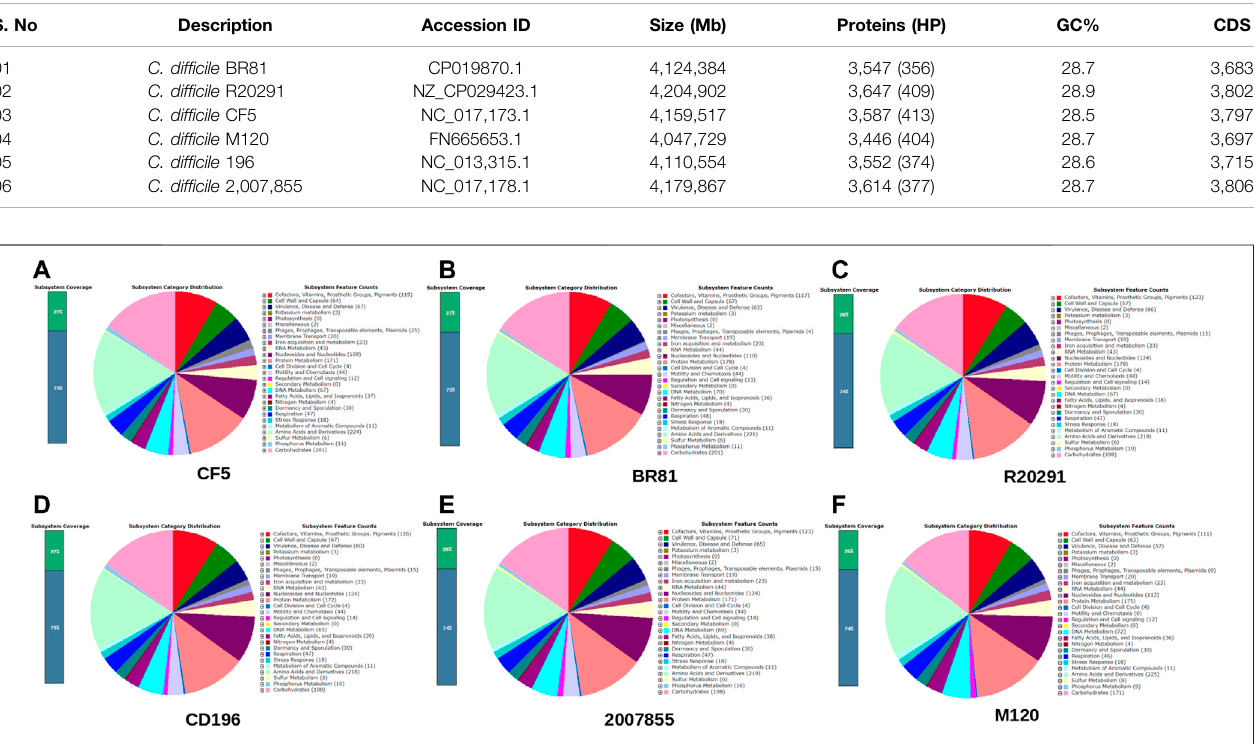
TABLE 1 | Characteristics of selected genomes of Clostriodioles strains.